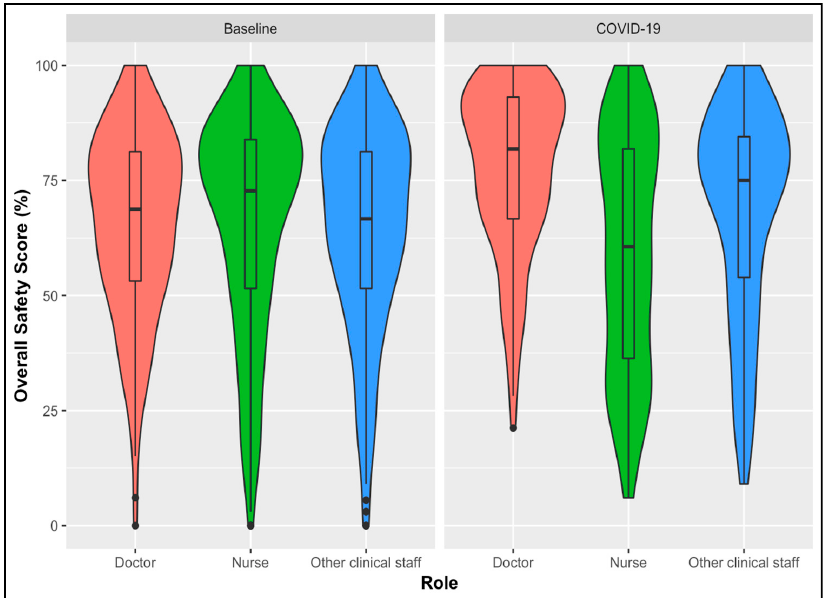
Figure 1. Violin plot demonstrating Safety Attitudes Questionnaire (SAQ) scores at baseline and during Covid-19, by profession. Width represents the proportion of respondents with a given score. Central line represents the median. Box represents interquartile range. Lines represent the range of scores. Dots represent outliers (more than 1.5 times the interquartile range). Scores represented as percentages.